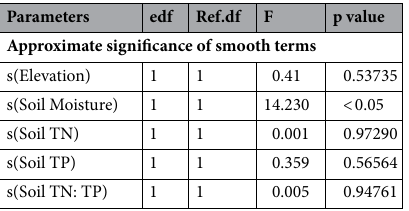
Table 1. General additive model for Salix spp. to find out correlation among parameters. R-sq.(adj) = 0.766 Deviance explained = 85.6%. GCV = 20.288 Scale est. = 11.593.